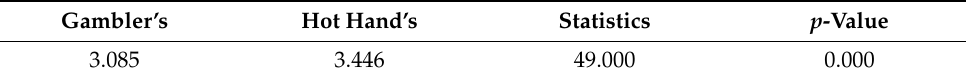
Table 3. Comparing gambler’s fallacy and hot hand